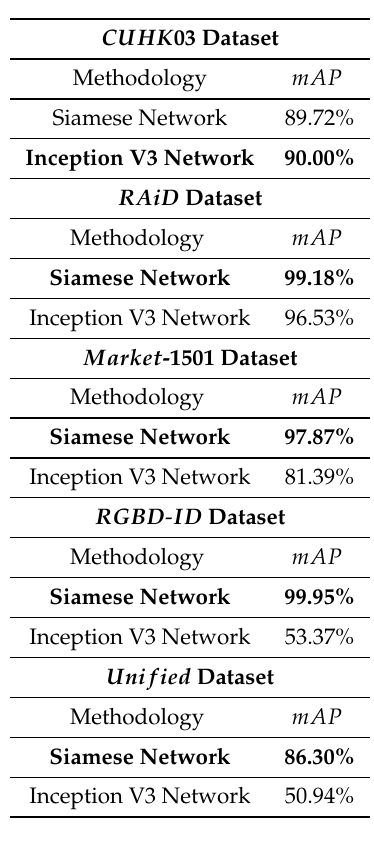
Table 8. Proposed Siamese versus Inception V3 network results per somatotype dataset.